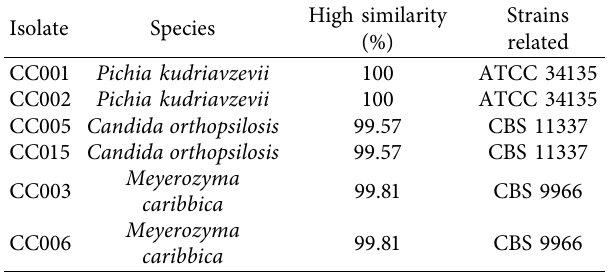
Table 2: Taxonomic identification of yeasts isolated from Myrciaria dubia .